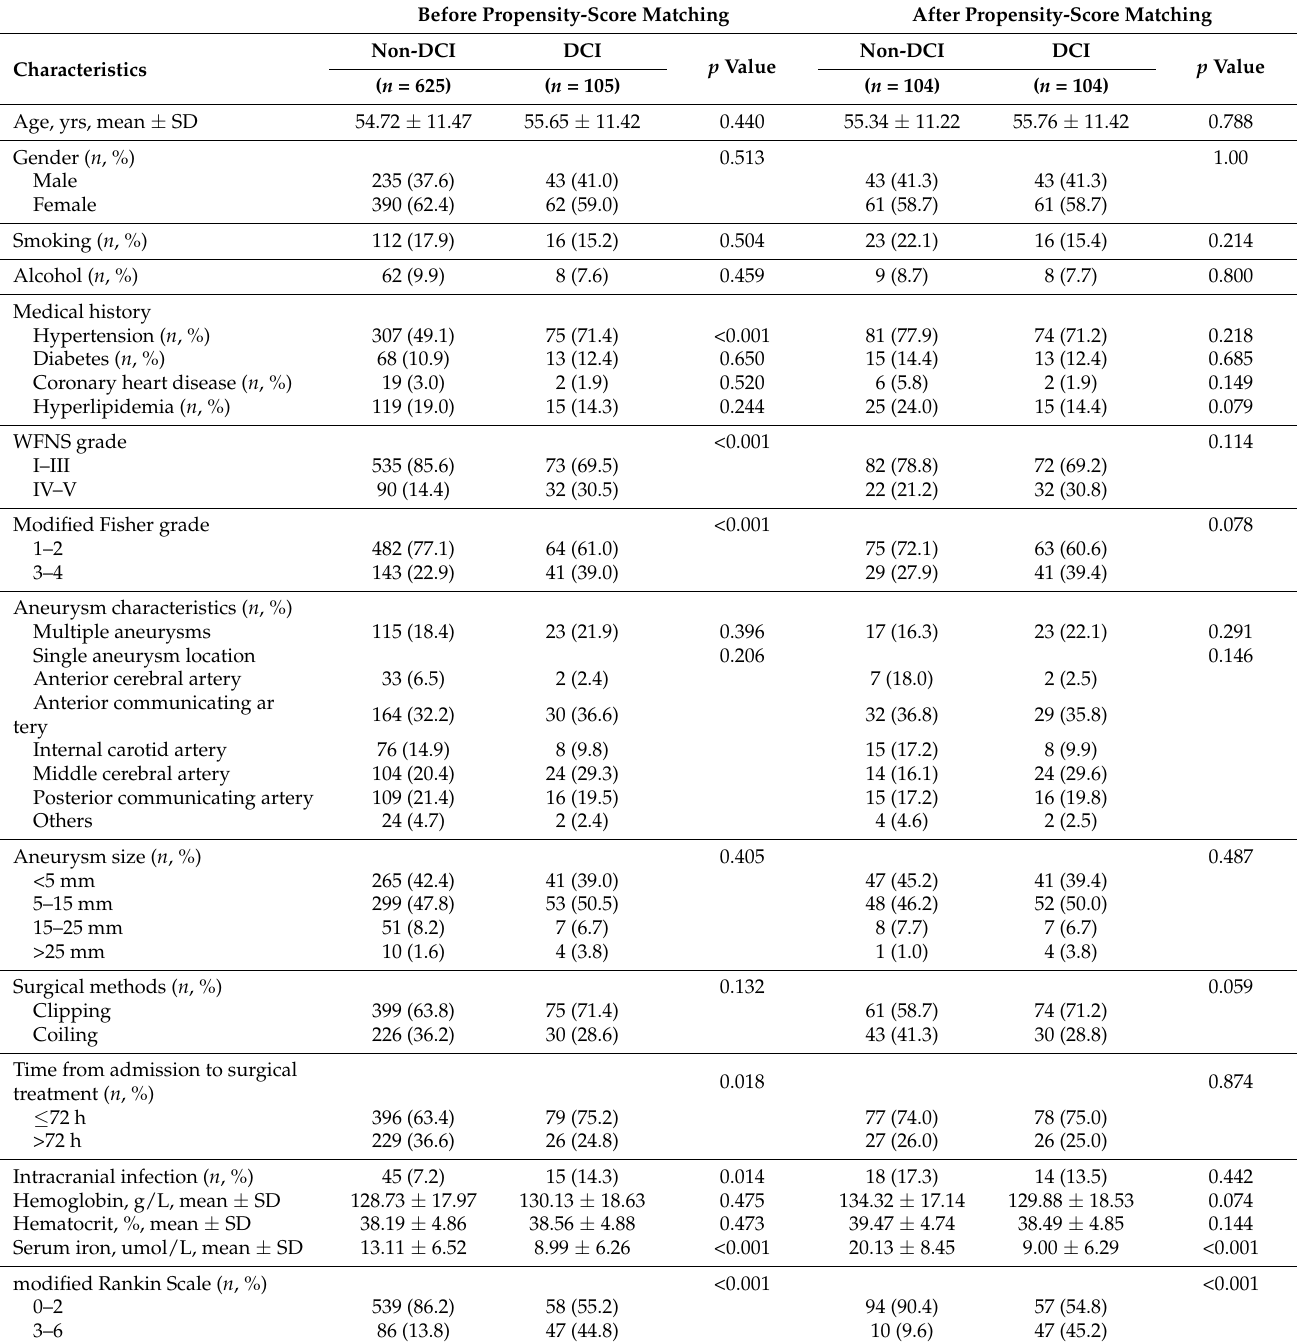
Table 1. Univariate analysis of association with DCI before and after propensity-score matching. Before Propensity-Score Matching After Propensity-Score